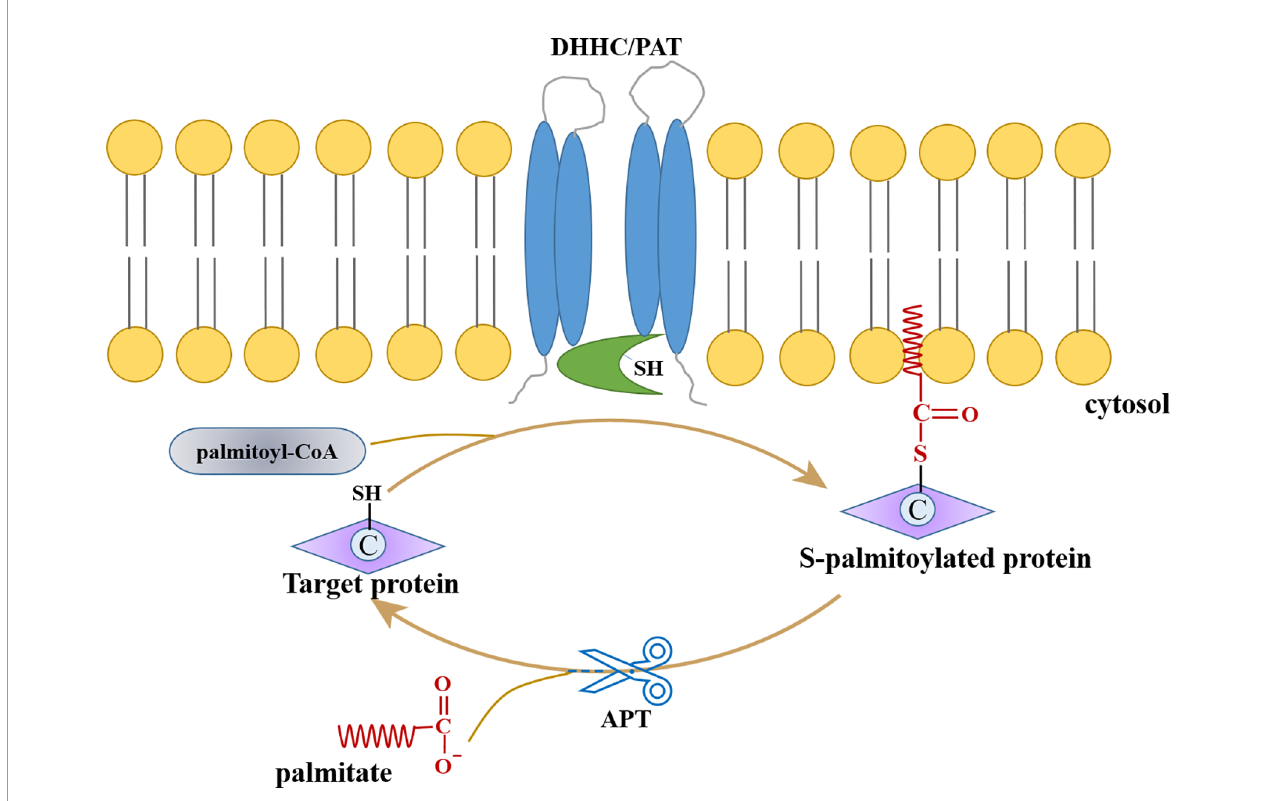
FIGURE 1 | Protein palmitoylation/depalmitoylation